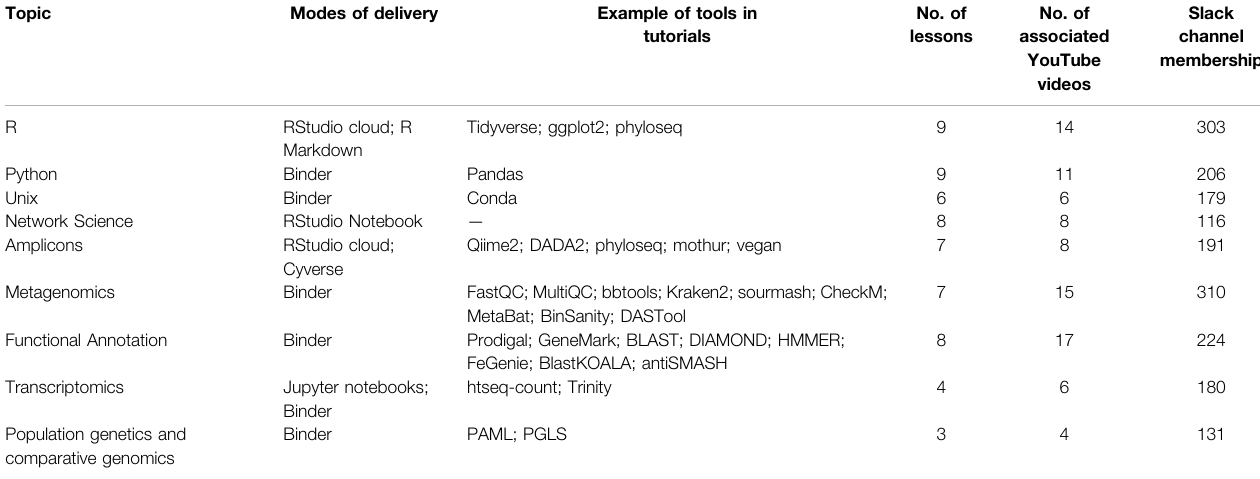
TABLE 1 | List of BVCN topics with how material was delivered, and examples of core concepts reviewed (https://github.com/biovcnet/biovcnet.github.io/wiki).